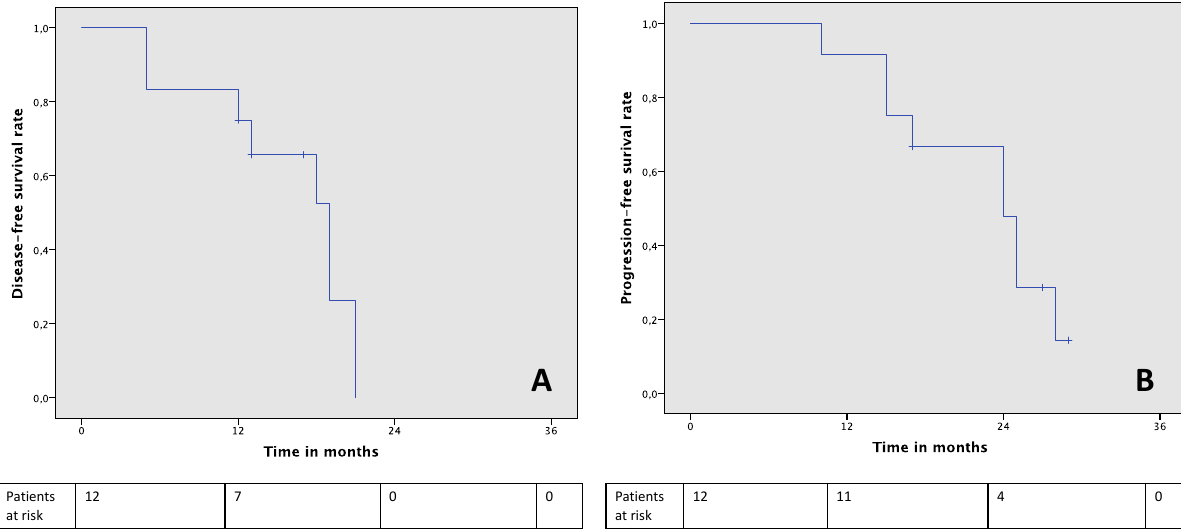
Figure 2. Disease-free survival curve ( A ) and progression-free survival curve ( B